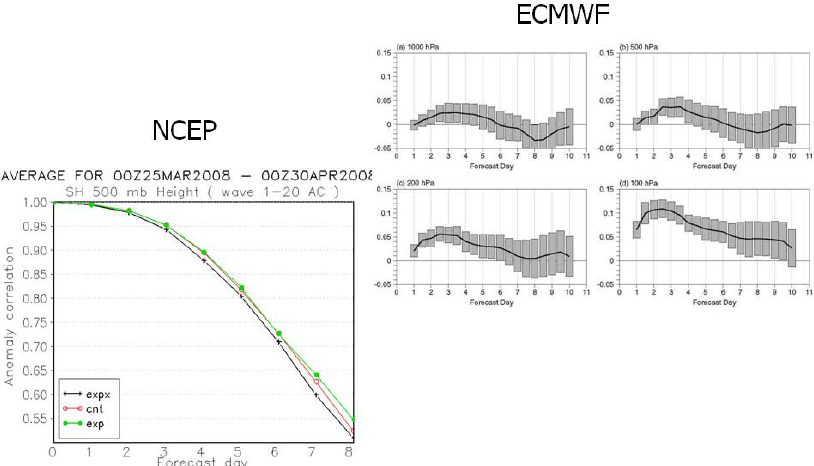
Fig. 28. Impacts of RO data in operational forecasts at NCEP (left, Cucurull, 2010) and the ECMWF (right, Healy, 2008). The NCEP data show the anomaly correlation for the 500-hPa height over the Southern Hemisphere in spring 2008. The use of COSMIC data adds 8h to the forecast skill at day 4 and 15h at day 7. The ECMWF data show the fractional reduction of the (a) 1000, (b) 500, (c) 200, and (d) 100hPa RMS temperature errors in the Southern Hemisphere, verified against radiosonde observations. Positive values represent improvement in terms of RMS errors. The vertical bars represent the 95% confidence interval. The COSMIC data reduced the fractional 100hPa temperature RMS errors by 11% for the 12-h forecasts over the Southern Hemisphere, which is a large signal. The corresponding improvement in the standard deviation of the 12-h forecast errors was 5%, showing that assimilating the RO measurements reduced both the random and systematic temperature